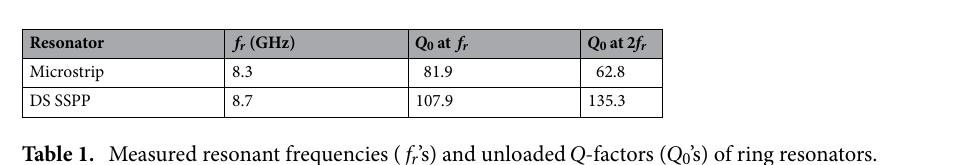
Table 1. Measured resonant frequencies ( f r ’s) and unloaded Q -factors ( Q 0 ’s) of ring resonators.